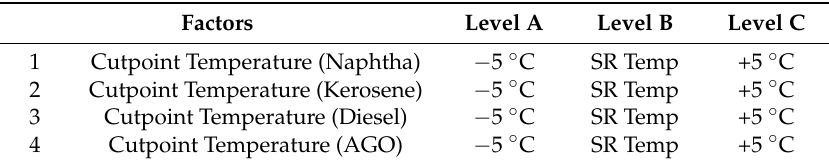
Table 5. Factors and levels for the optimization of CDU [21].